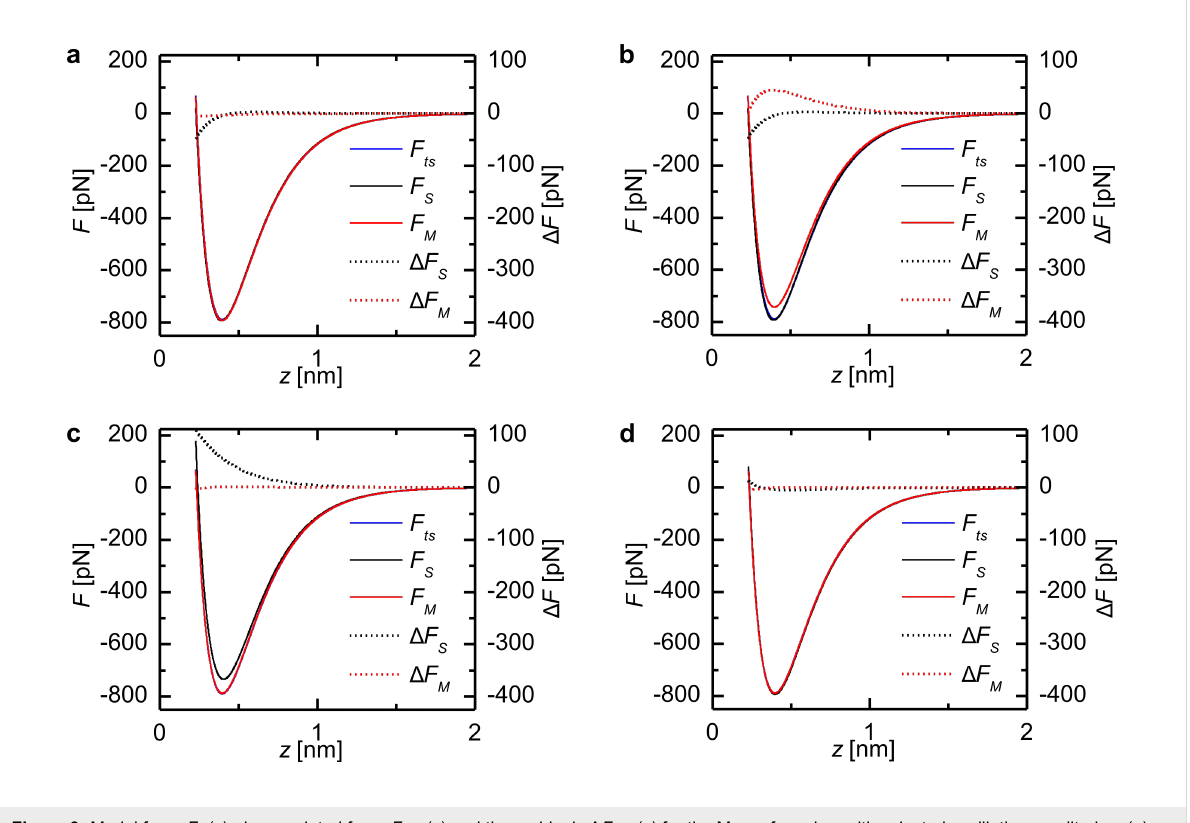
Figure 3: Model force F ts ( z ), deconvoluted force F S / M ( z ) and the residuals Δ F S / M ( z ) for the Morse force law with selected oscillation amplitudes. (a) Amplitude 1 in Figure 2 (12.8 pm) with R 2 ≈ 1 for the matrix method. (b) Amplitude 2 in Figure 2 (12.9 pm) with R 2 = 0.995 for the matrix method. (c) Amplitude 3 in Figure 2 (137 pm) with R 2 = 0.990 for the Sader–Jarvis method. (d) Amplitude 4 in Figure 2 (352 pm) with R 2 ≈ 1 for both